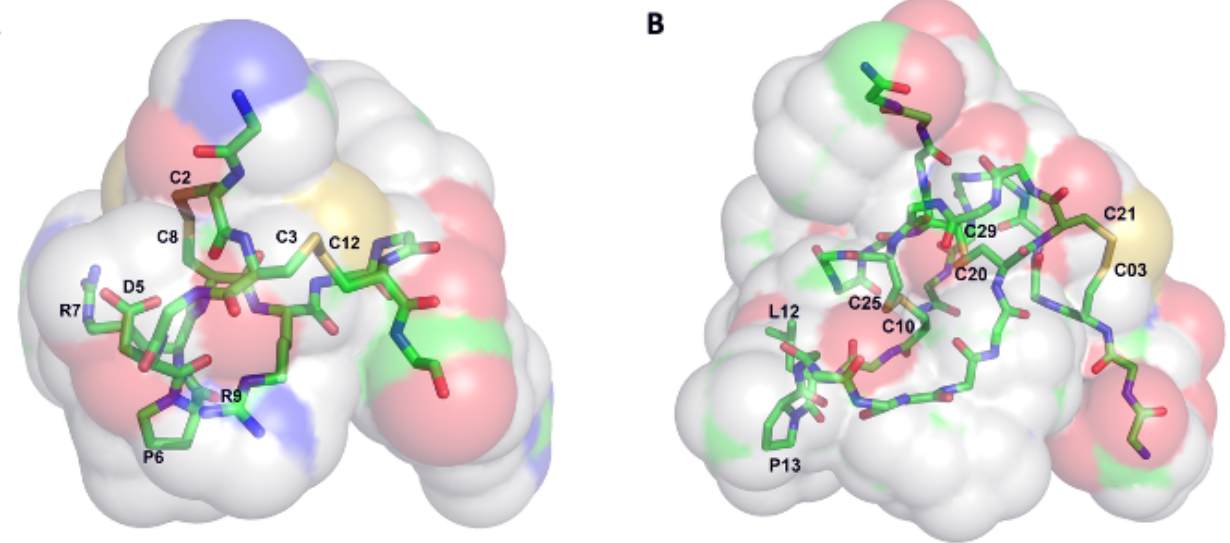
Figure 3. Three-dimensional structures of conotoxins. (A) Three-dimensional structure of RgIA, an α-conotoxin from the Conus regius venom, classified into A superfamily, cysteine framework I, and fold A. The residues involved in the interaction with α9α10 nAChRs – D5, P6, and R7, and the residue that determines selectivity – R9, are highlighted. (B) Three-dimensional structure of the cis-isomer of EVIA, a δ-conotoxin from Conus ermineus venom, classified into O1 superfamily, cysteine framework VI/VII, and fold C. The L12-P13 residues, which are connected by a peptide bond that shows a 1:1 cis/trans isomerism, are highlighted. Both structures are represented as stick models with surface models on the background. The images were produced using PyMOL [66], from the models 2JUS for RgIA [64] and 1GIZ for EVIA [67] deposited on the Protein Data Bank (PDB –